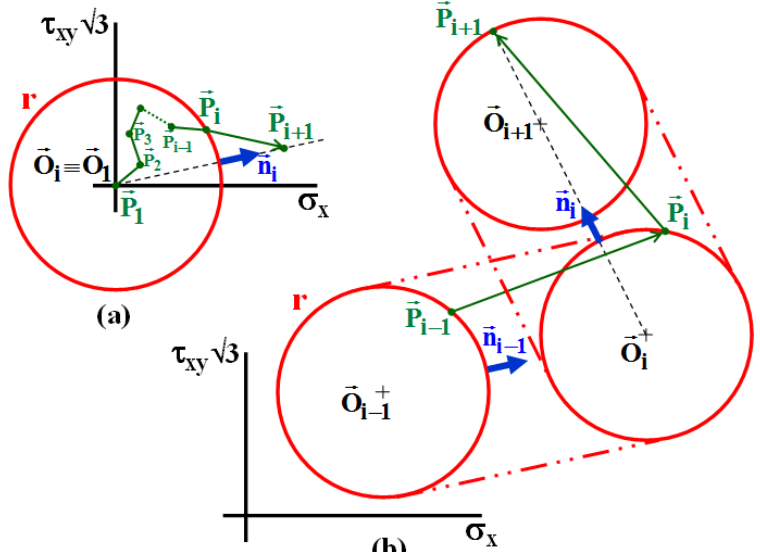
Figure 5: Hyper-surface location (a) during its first translation and (b) during a load kinking. In summary, static filtering happens while the next peg location Fig. 3, while dynamic filtering happens during hyper-sphere translations where b i > r , a i  0 , and d i  r . Besides the